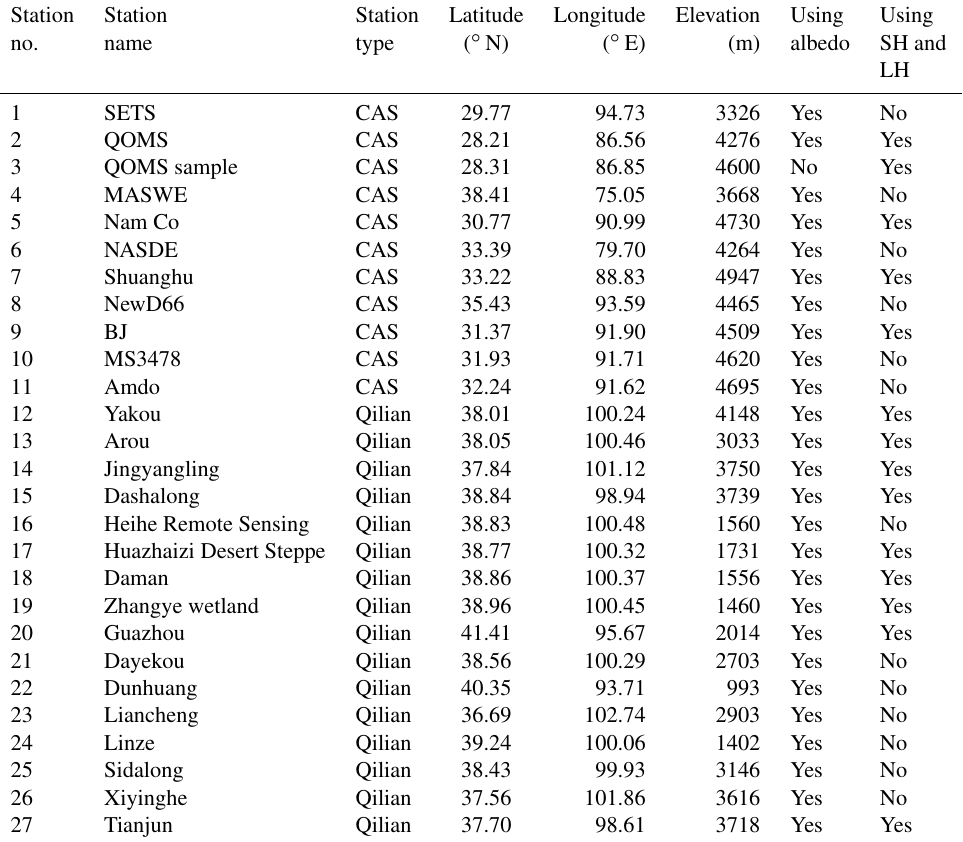
Table 2. Locations of stations from the Chinese Academy of Sciences (CAS) and the Qilian Mountains integrated observatory network and whether or not observations of albedo, SH and LH were used from each